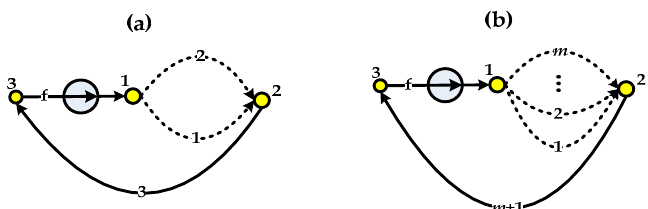
Figure 3. Secondary-side fluid flow network (FFN) of ( a ) 2 and ( b ) m modular IRIS plant by feedwater distribution.